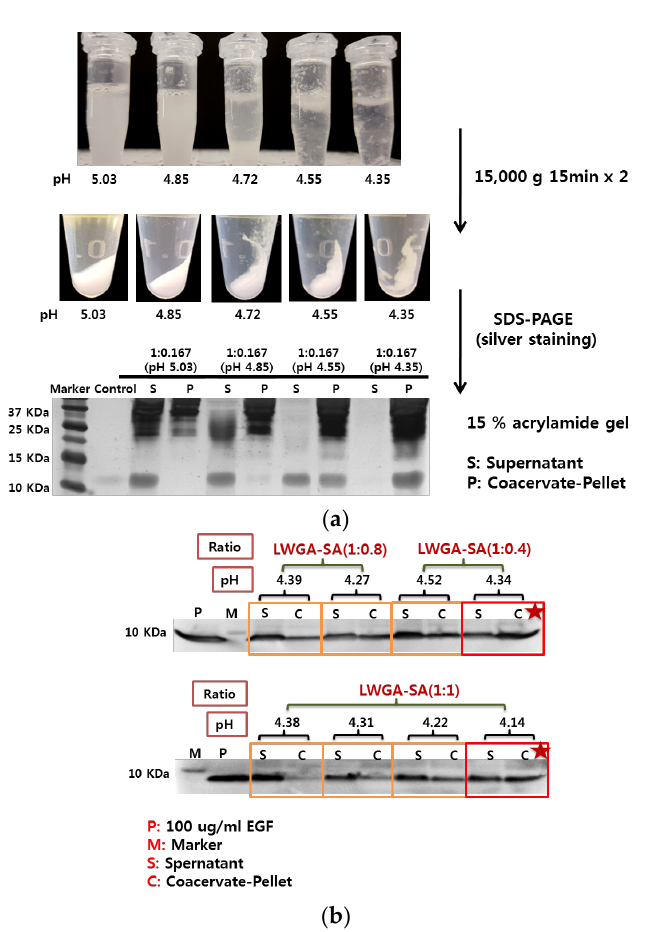
Figure 3. Qualitative analysis of epidermal growth factor (EGF) by Western blot in various GA-SA reaction mixtures. ( a ) Appearance of HWGA-SA (1:0.167) as a function of reaction pH, and EGF in the supernatants and pellets determined by Western blot after centrifugation. ( b ) EGF in the supernatants and pellets from eight different reaction conditions of LWGA-SA. Sample loading was 20 μL per well. P: EGF solution, M: marker, S: supernatant, P: pellet.